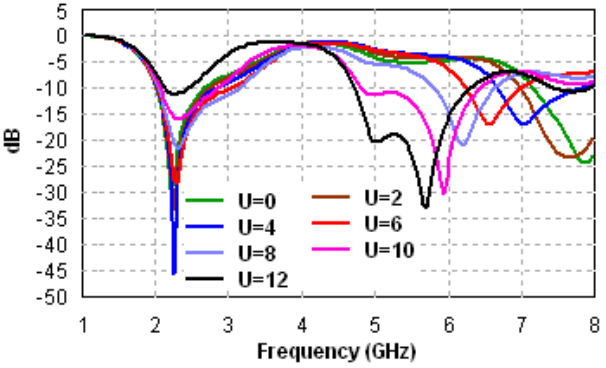
Figure 11: The S 11 responses of the 3rd iteration Koch fractal monopole antenna of Figure 6(b) with U, (in mm), as the parameter.